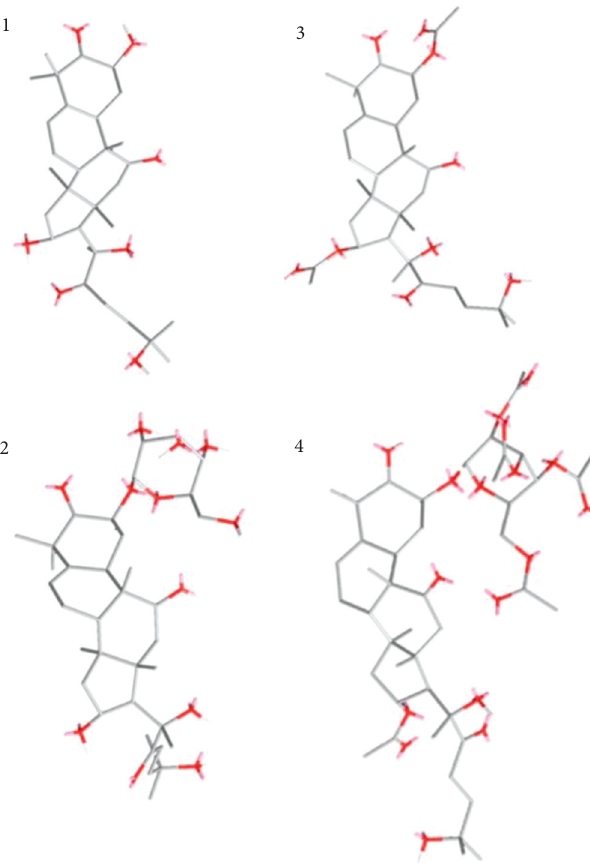
Figure 4: The lowest-energy conformations of 1, 2, 3, and 4 were determined with chembio 3 ultra 13.0. Only the polar hydrogens are shown (energy 1 79.305, energy 2 103.2813, energy (cid:31) (cid:31) 3 85.2036, and energy 4 (cid:31) (cid:31)